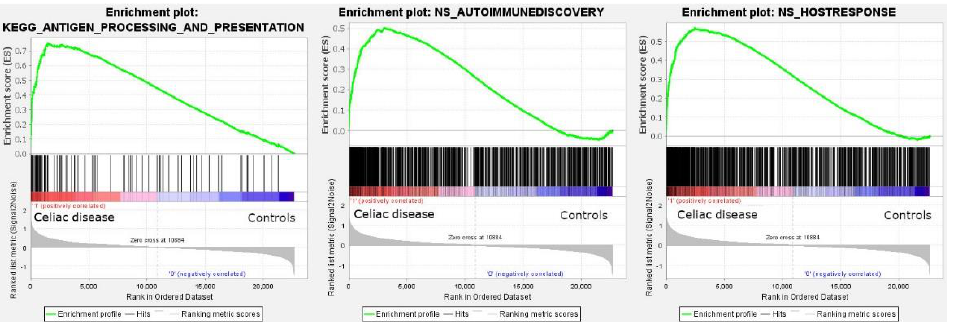
Figure 2. Gene set enrichment analysis (GSEA). GSEA analysis was performed to identify gene sets (i.e., pathways) associated with celiac disease. All the sets of the nine major collections of the Molecular Signatures Databases were tested and 5600 sets were significantly enriched at a nominal p value of <1%. Among them, the antigen processing and presentation is highlighted (left). The autoimmune discovery transcriptome panel and additional panels were also tested, and showed an enrichment (association) toward celiac disease (autoimmune discovery panel, center; host immune response panel,